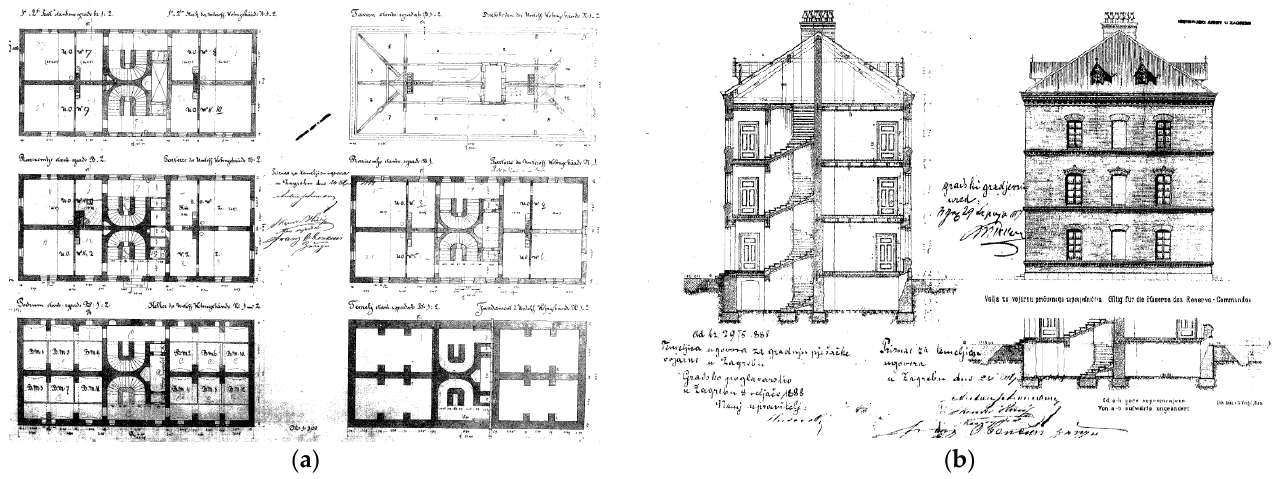
Figure 4. ( a ) Original floor plans of the buildings from the archive; ( b ) Original cross-section plans of the buildings from the archive.